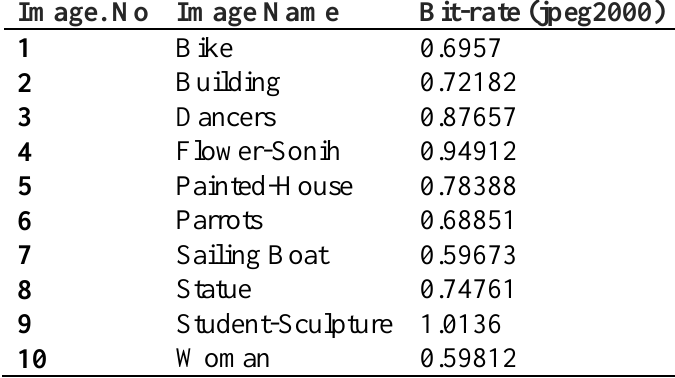
Table 1. Name of images with their corresponding bit-rate (compressed by